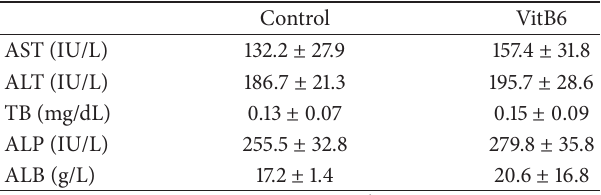
Table 2: The indexes for liver function in mice.